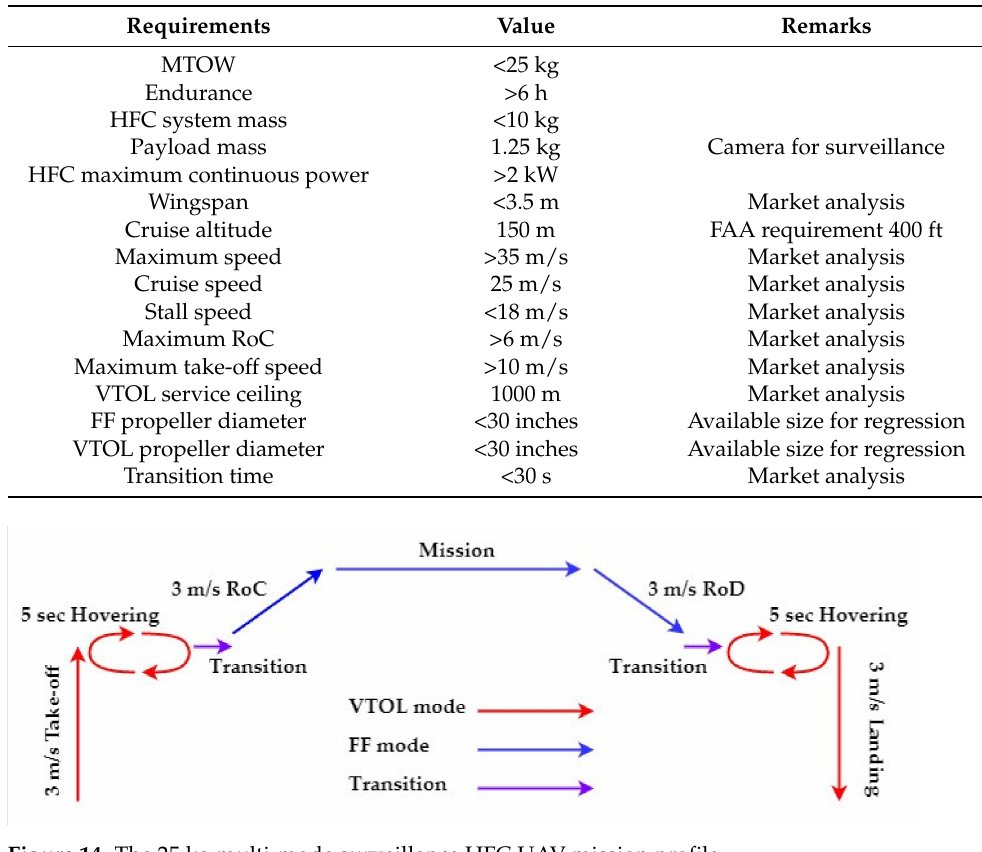
Figure 14. The 25 kg multi-mode surveillance HFC UAV mission